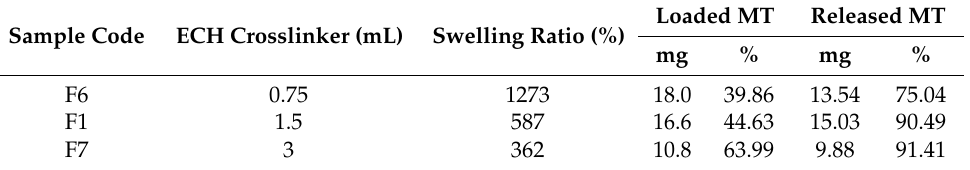
Table 4. The dependence of the swelling, loading and releasing capacity on the crosslinker amount (the other reaction parameters are considered